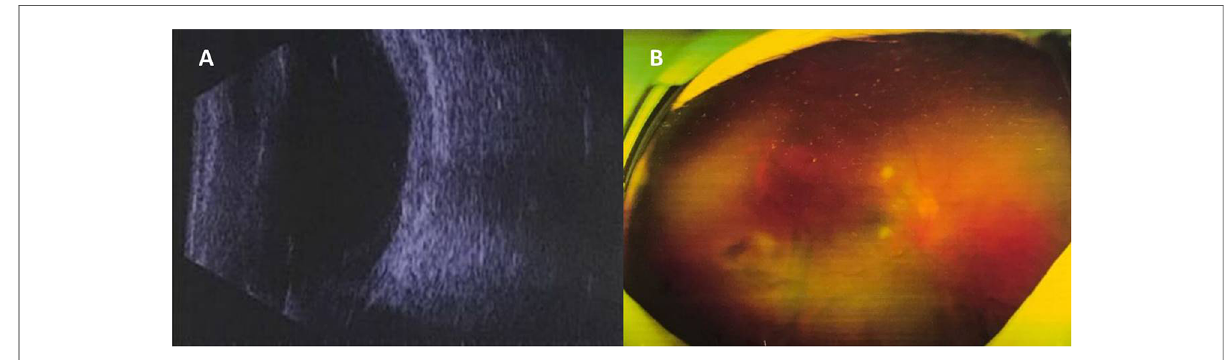
FIGURE 2 Fundus fi ndings after surgery: case 1. ( A ) B-ultrasound scan showing slight turbidity of the vitreous body and vitreous organization after surgery. ( B ) Vitreous hemorrhage was partially absorbed and the optic nerve head could be seen faintly after